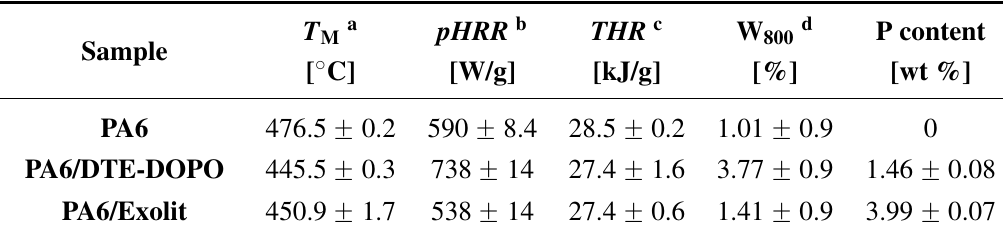
Figure 6. HRR versus temperature for PA6 formulations ( a ) and comparative HRR and mass loss derivative for the PA6/DTE-DOPO formulation ( b ). Table 3. PCFC data for PA6 and PA6 formulations.